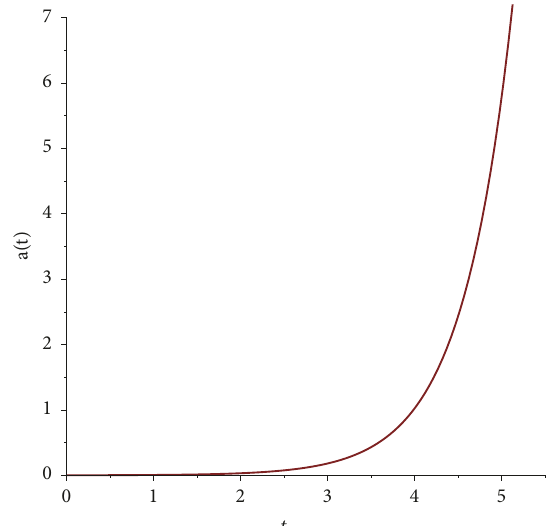
Figure 1: The universe scale factor for the inflation period (where 𝛼 = 1,𝑚 = 1, 𝑛 = 2 .)